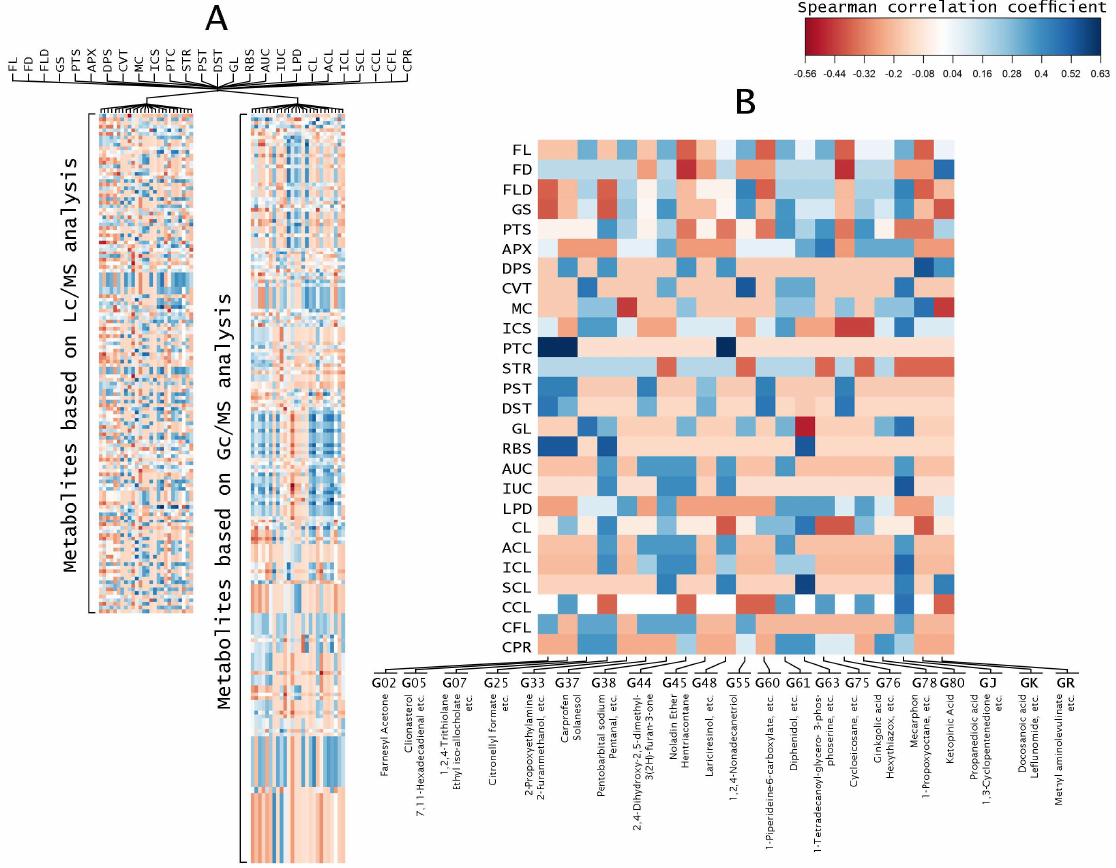
Figure 2. Heat map of correlations between eggplant fruit metabolites and fruit morphologies. Each square represents the Spearman’s correlation coefficient ( p < 0.05). ( A ) Heat map of correlations between eggplant fruit metabolites based on 136 detected peaks of LC-MS analysis and 207 detected peaks of GC-MS analysis with 26 fruit morphologies; ( B ) Heat map of correlations between specific eggplant fruit metabolites of each accession with 26 fruit morphologies.